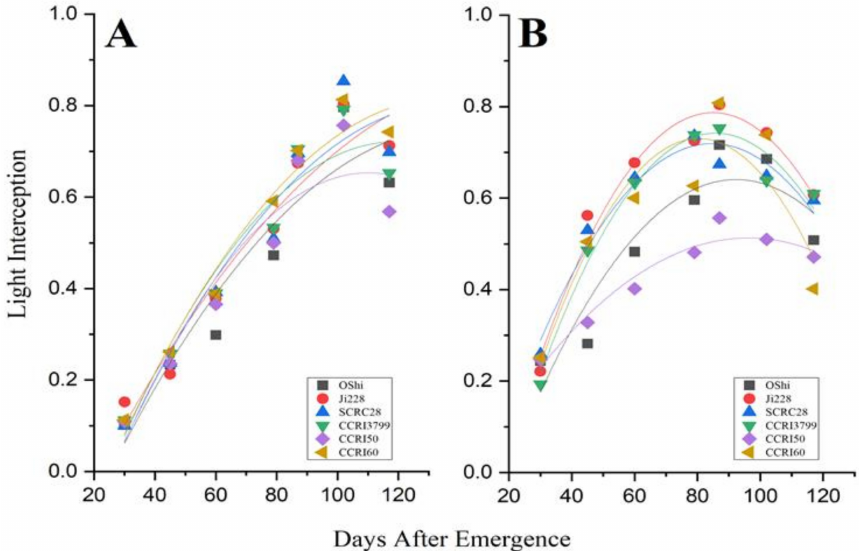
Figure 2. The distribution of Intercepted Photosynthetically Active Radiation (iPAR) during entire cotton- growing season for OShi, Ji228, SCRC28, CCRI3799, CCRI50, and CCRI60 in 2018 ( A ) and 2019 ( B